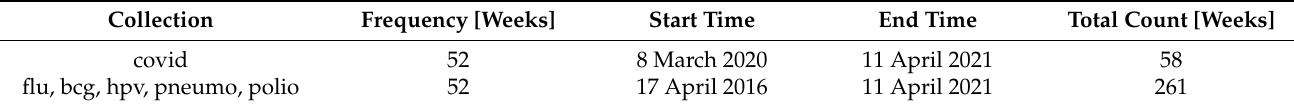
Table 1. Descriptive statistics of time series data